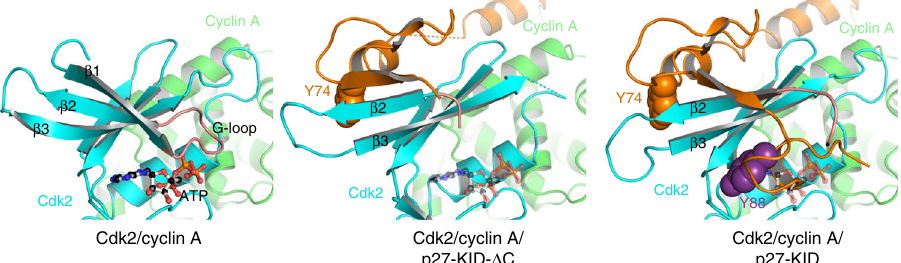
Fig. 3 Y phosphorylation displaces the D2 region of p27 from Cdk2, mediating reactivation. a NMR analysis of the in fl uence of tyrosine phosphorylation on interactions between p27-KID and Cdk2/cyclin A. Chemical shift differences for residues in non-phosphorylated (top) and tyrosine-phosphorylated (pY88- p27-KID, middle; and pY74/pY88-p27-KID, bottom) p27-KID bound to Cdk2/cyclin A. Chemical shift differences were calculated from the free and Cdk2/ cyclin A-bound state for each phospho-species. Residues near Y88 and within the entire D2 subdomain adopt free state-like conformations in pY88-p27- KID and pY74/pY88-p27-KID, respectively. Δδ values were calculated using the equation: Δδ = [( Δδ 1 H N ) 2 + 0.0289 × ( Δδ 15 N H ) 2 ] 1/2 . b Views of the region of Cdk2 (cyan) bound by p27 (orange) in various structures of Cdk2/cyclin A: Cdk2/cyclin A/ATP (PDB 1JST, left; ATP is shown in ball and stick format), Cdk2/cyclin A/p27-KID- Δ C (determined in this study, middle; a model of ATP is shown in semi-transparent ball and stick format), and Cdk2/ cyclin A/p27-KID (PDB 1JSU; the position of ATP in the absence of p27 is shown in semi-transparent ball and stick format). Both p27-KID- Δ C and p27-KID displace β -strand 1 ( β 1) from the N-terminal β -sheet of Cdk2 but, due to deletion of residues displaced by phosphorylation of Y88 in p27-KID- Δ C, the active site is accessible to ATP (modeled based upon the Cdk2/cyclin A/ATP structure). However, displacement of the β 1 strand of Cdk2 (including residues of the G-loop) in the Cdk2/cyclin A/p27-KID- Δ C structure gives rise to an incompletely formed ATP-binding pocket, consistent with the